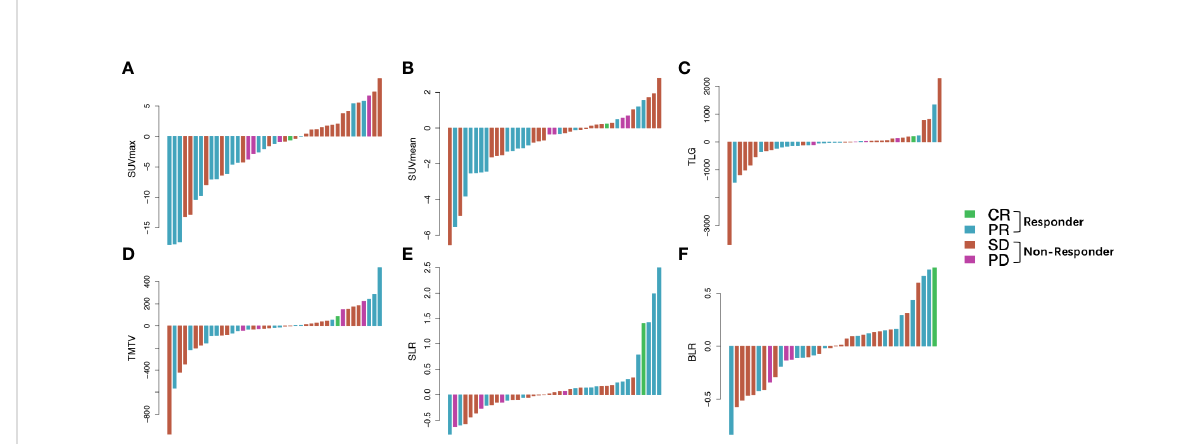
FIGURE 2 Waterfall plots of the D SUVmax (A) , D SUVmean (B) , D TLG (C) , D TMTV (D) , D SLR (E) , and D BLR (F) before and after ICI treatment according to treatment response. Responder: PR and CR; non-responder, SD and PD. D indicates interval changes in the PET/CT parameters of